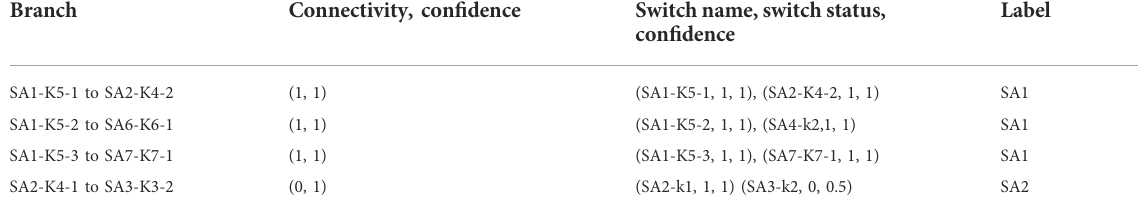
TABLE 7 Topology table of SA1 in Round 2.